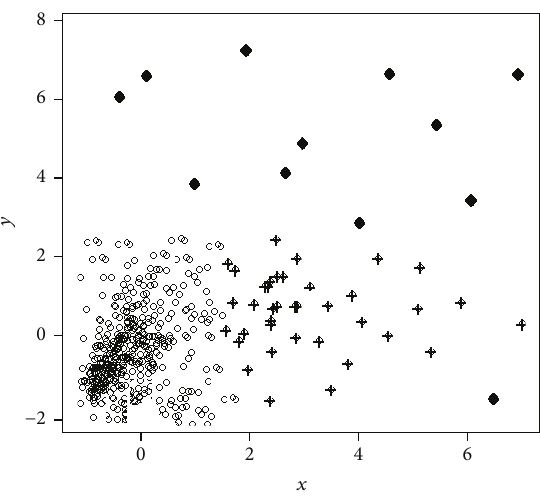
Figure 7: Outliers detected for distance-based CBC. Table 5: Best results of outlier detection using CBR (CBC)